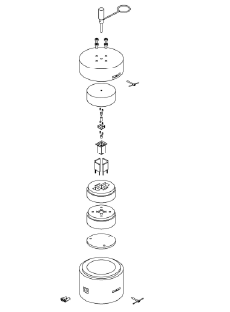
Figure 1. Immersion calorimeter.